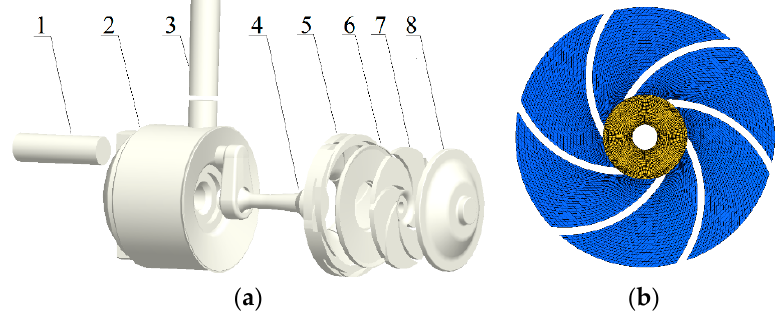
Figure 7. Grid diagram of the impeller and computational domain of model pump. 1: Inlet pipe; 2: Pump body Outlet pipe 3: Outlet pipe; 4: Jet; 5: Guide vane; 6: Front pump cavity; 7: Impeller; 8: Back pump cavity. ( a ) Computational domain of the model pump; ( b ) Grid diagram of impeller.